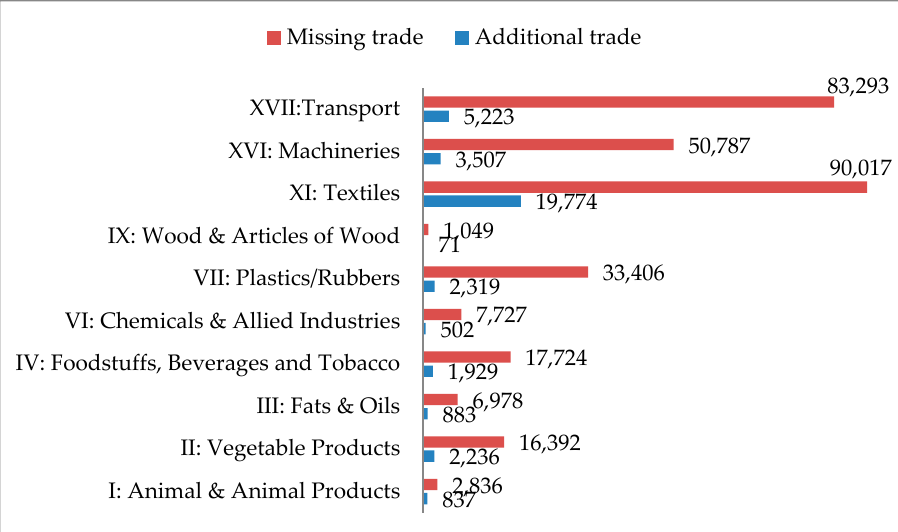
Figure 6. Trade effect due to protection: Results for sectors with significant preference impacts (CES reference tariff). At world prices; millions of €. Source: Elaboration on data by COMEXT and TRAINS; 2017.